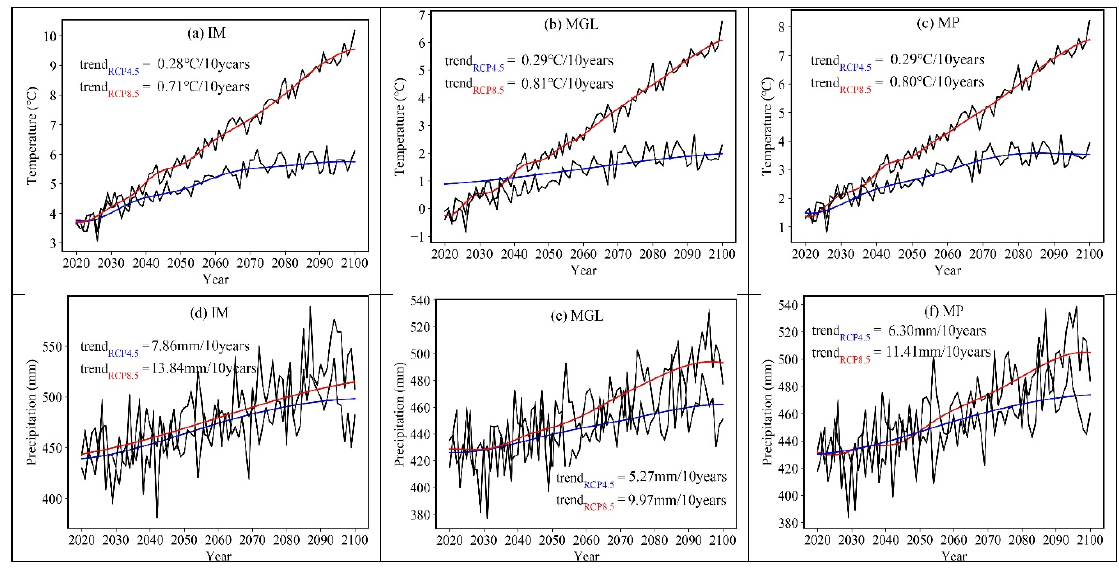
Figure 3. Future temporal trends in temperature and precipitation in Inner Mongolia ( a , d ), Mongolia ( b , e ) and the Mongolian Plateau ( c , f ) during 2020–2100. The black lines indicate the annual series of temperature and precipitation, whereas the blue and red lines denote the empirical mode decomposition (EMD) trend components under the representative concentration pathway RCP4.5 and RCP8.5 scenarios.